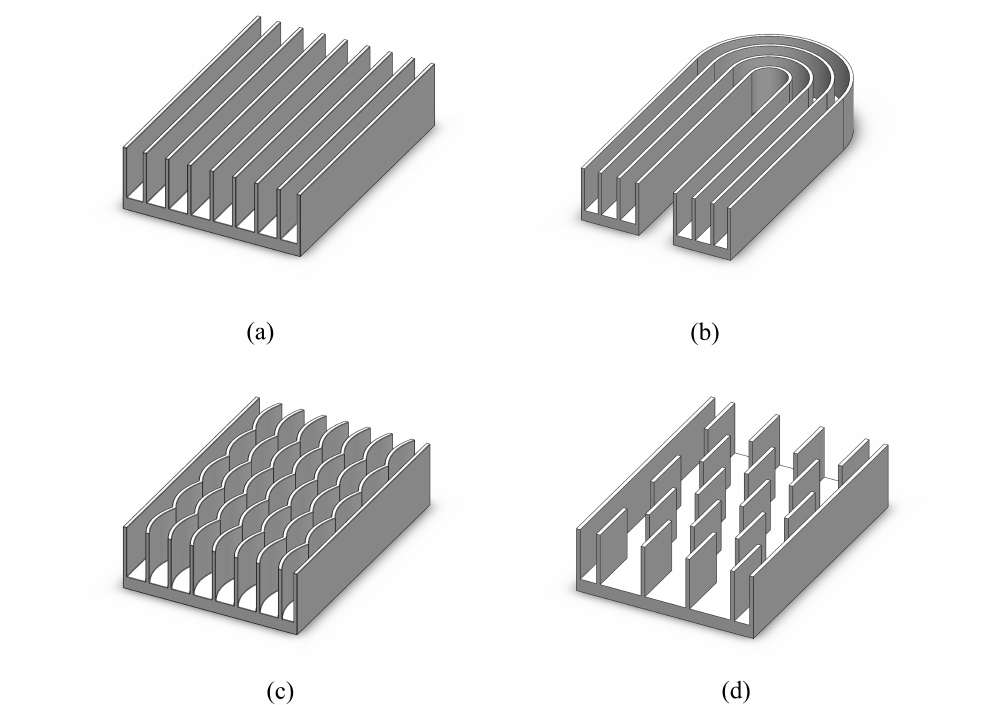
Figure 2. Schematics of a heatsink with ( a ) Conventional straight microchannels, ( b ) U-turn path, ( c ) Parallel curvy microchannels, ( d ) Offset strip